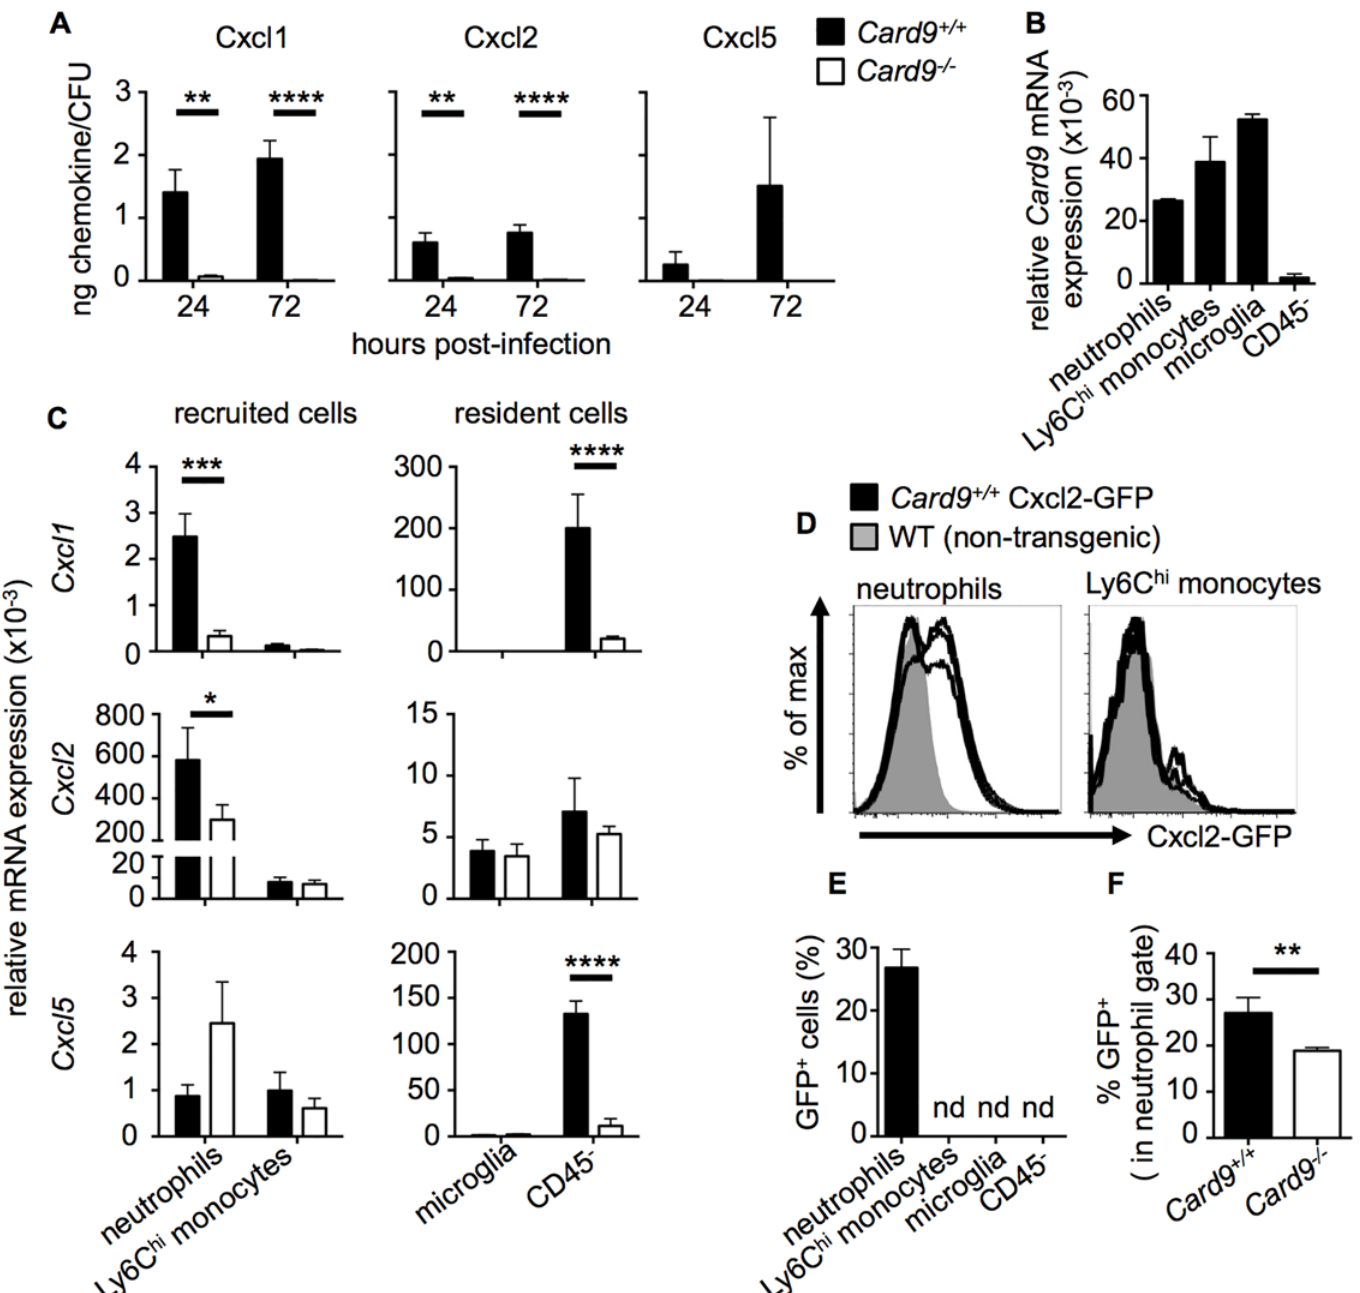
Fig 8. CARD9 is required for neutrophil-targeted chemokine production during fungal infection of the CNS. (A ) Whole brain homogenates were analyzed for Cxcl1, Cxcl2 and Cxcl5 in WT (filled bars, n = 6) and Card9 -/- (empty bars, n = 6) mice by Luminex array. Chemokine concentration (ng/g) was expressed relative to the mean brain fungal burden (CFU/g). Mice analyzed at 24 hours were infected with 1.3x10 5 CFU SC5314, and mice analyzed at 72 hours infected with 7x10 4 CFU. Data is pooled from two independent experiments and analyzed by two-way ANOVA (with Bonferroni correction). ( B ) Relative expression of Card9 mRNA by indicated cell populations FACS-sorted from WT brains at 24 hours post-infection (n = 3). ( C ) Neutrophils, Ly6C hi monocytes, microglia and CD45 - cells were FACS-sorted from WT and Card9 -/- brains at 24 hours post-infection (inoculum: 1.3x10 5 ) and RNA purified for qRT-PCR analysis of Cxcl1 , Cxcl2 and Cxcl5 expression. See S11 Fig for purity analysis. Data is pooled from nine (neutrophils, Ly6C hi monocytes, microglia) or six sorts (CD45 - cells) and analyzed by two-way ANOVA (with Bonferroni correction). ( D ) Transgenic Cxcl2-GFP reporter animals (black histograms) were infected with 1.3x10 5 CFU and brain leukocytes analyzed by FACS at 24 hours post-infection. Expression of GFP within the indicated cell populations was compared to non-transgenic WT animals (grey histograms). Histograms are representative of two independent experiments. ( E ) Quantification of the frequency of GFP + cells within the indicated cell populations and ( F ) percentage of GFP + neutrophils within the WT and Card9 -/- brain;